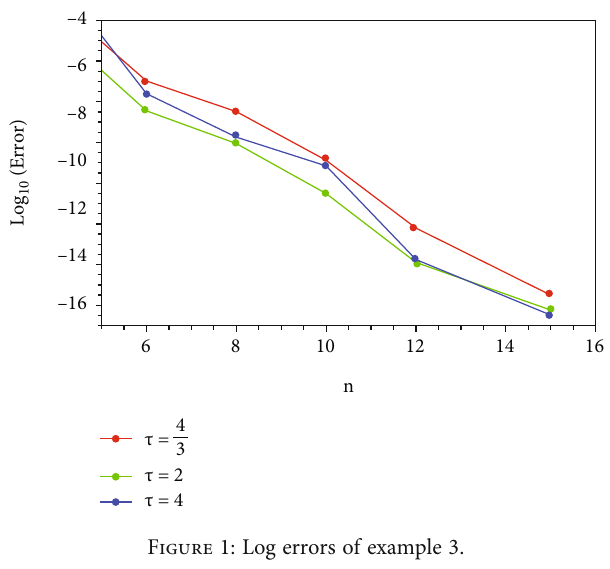
Figure 1: Log errors of example